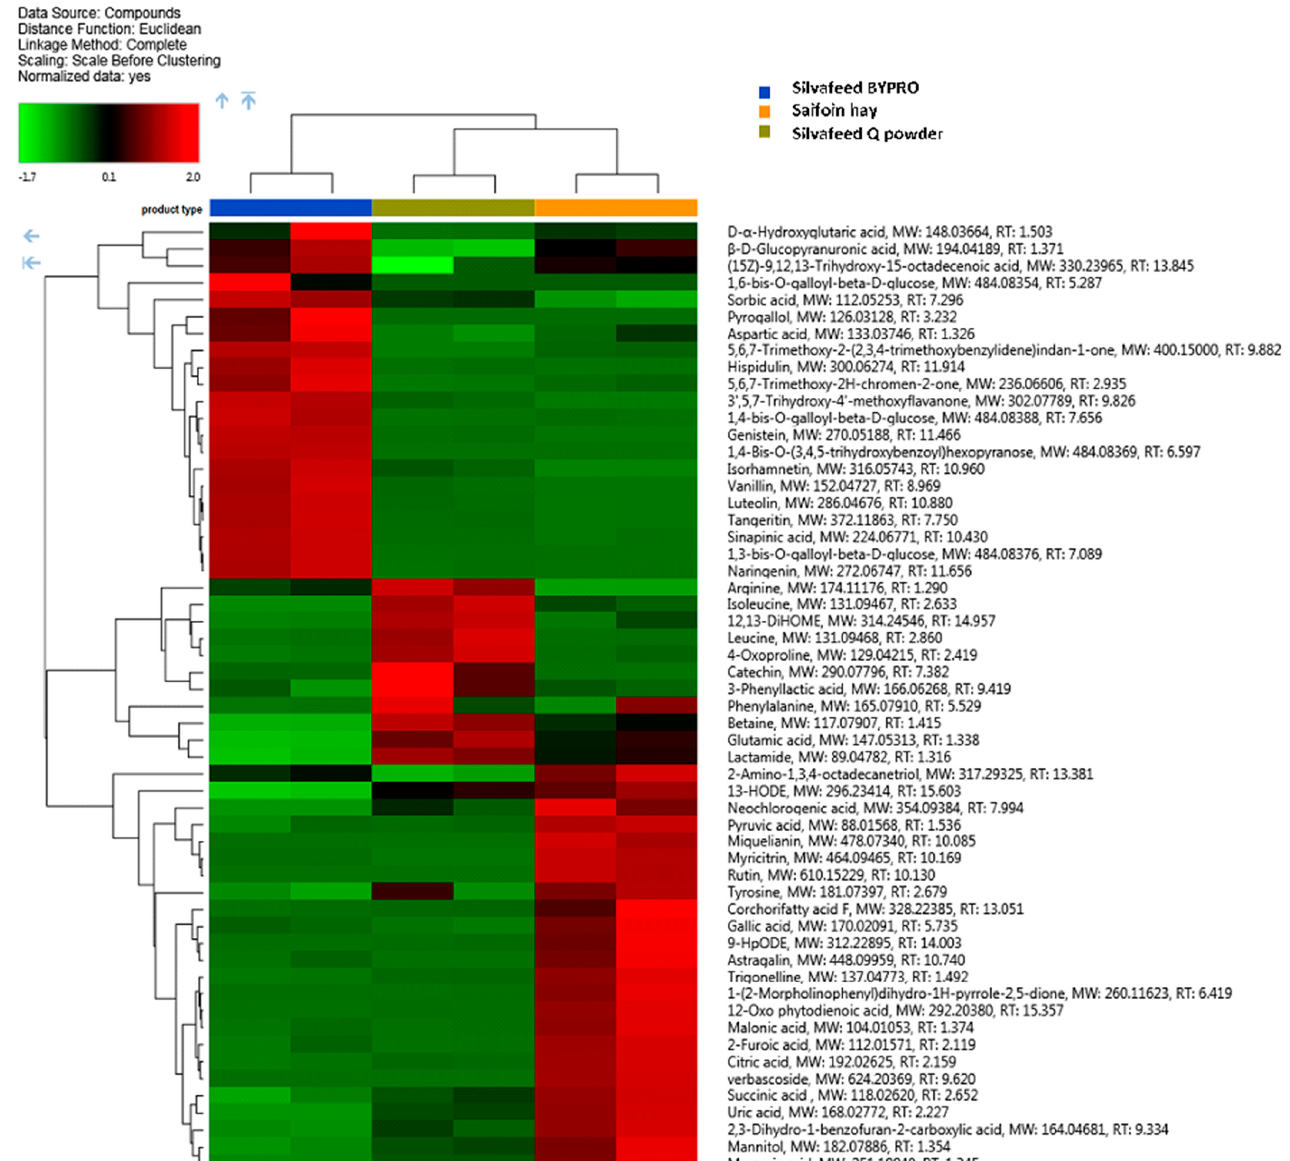
Figure 2. Hierarchical cluster analysis for the 55 most abundant species of hydrolysable tannins identified in water extracts. Heatmap reflecting the differences between relative amount through normalized chromatographic peak areas in respect to sample type; z-color scale indicates normalized peak area value: red and green indicates more and less abundant, respectively.